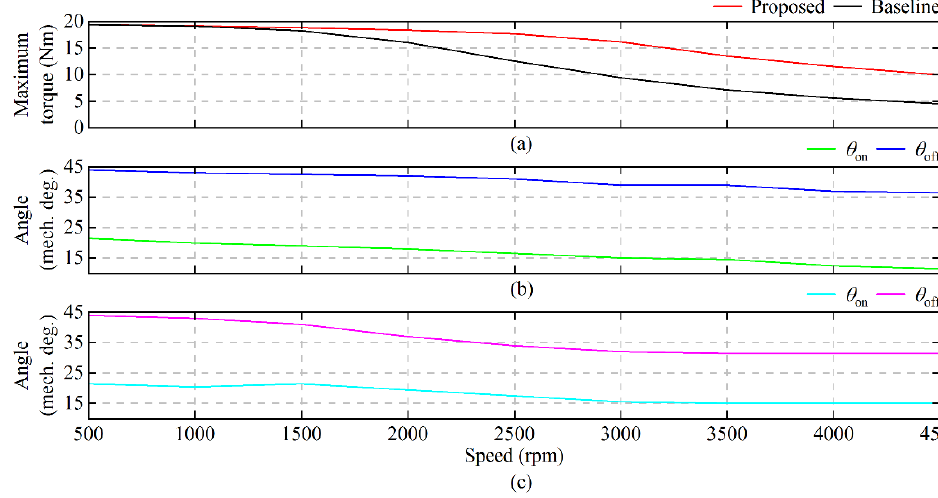
Figure 20. Maximum torque-speed characteristics of the three-phase SRM drive ( a ). Optimal turn-on and turn-off angles with the proposed scheme ( b ), and the baseline scheme ( c ).